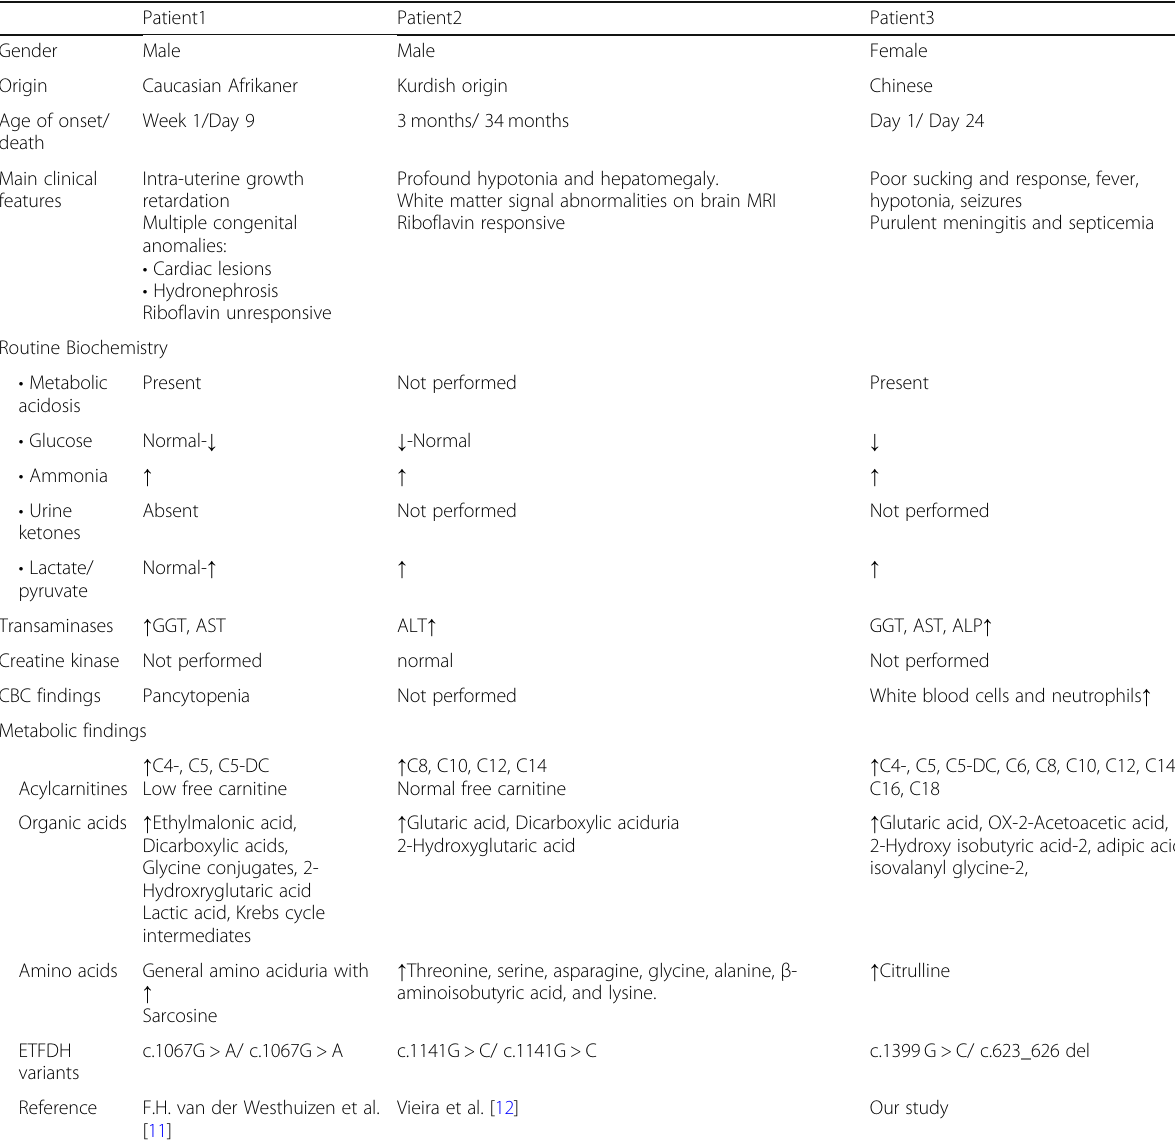
Table 3 Summary of clinical, biochemical and genetic features associated with ETFDH variants of neonatal GA II Patient1